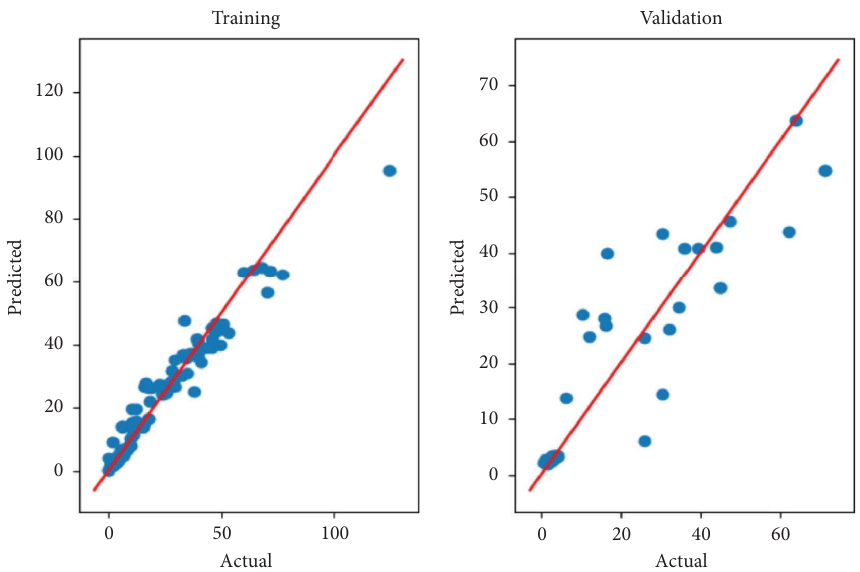
Figure 9: Te actual and predicted values of training and testing sets using RF. Feature importance graph